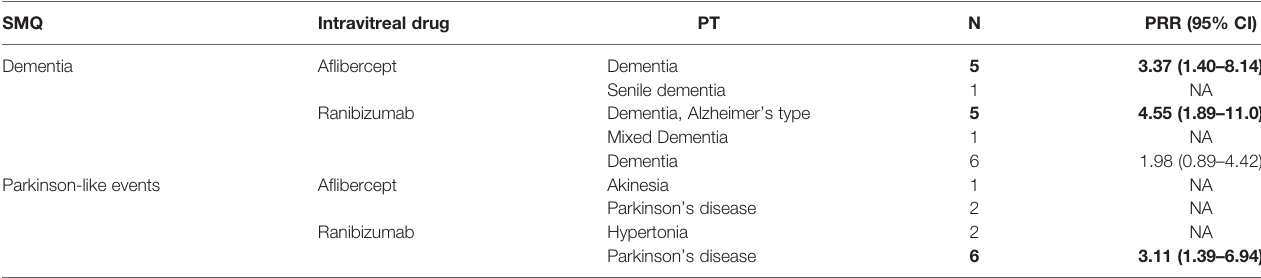
TABLE 2 | Individual case safety reports for intravitreal ranibizumab, a fl ibercept, and bevacizumab grouped by preferred term related to dementia and/or Parkinson-like events standardized MedDRA queries, in patients of all ages. SMQ